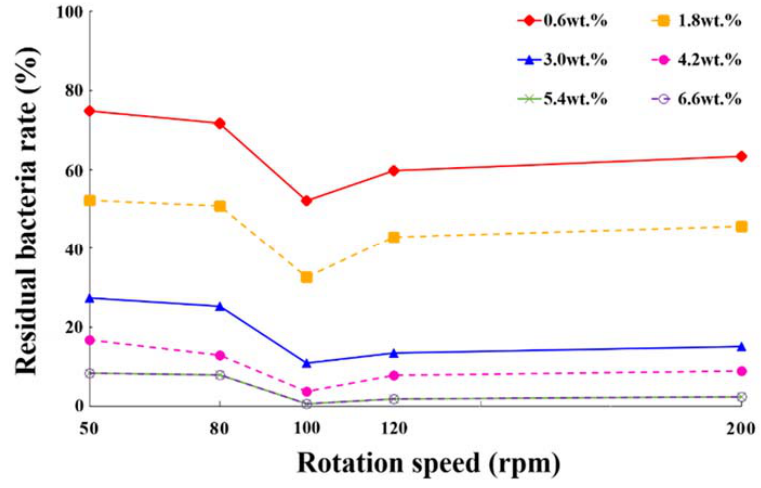
Figure 5. Residual bacterial rate under different Ag/Fe 3 O 4 concentrations and motor driving frequencies.